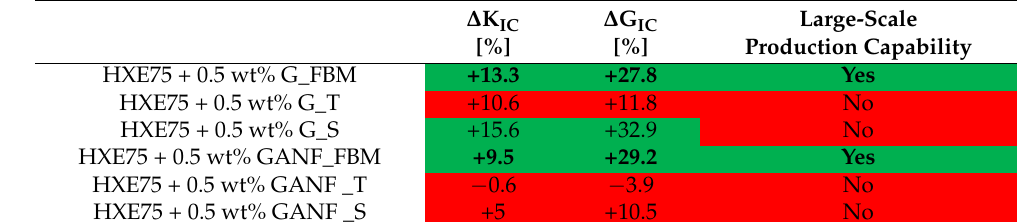
Table 6. Decisional analysis of the investigated material